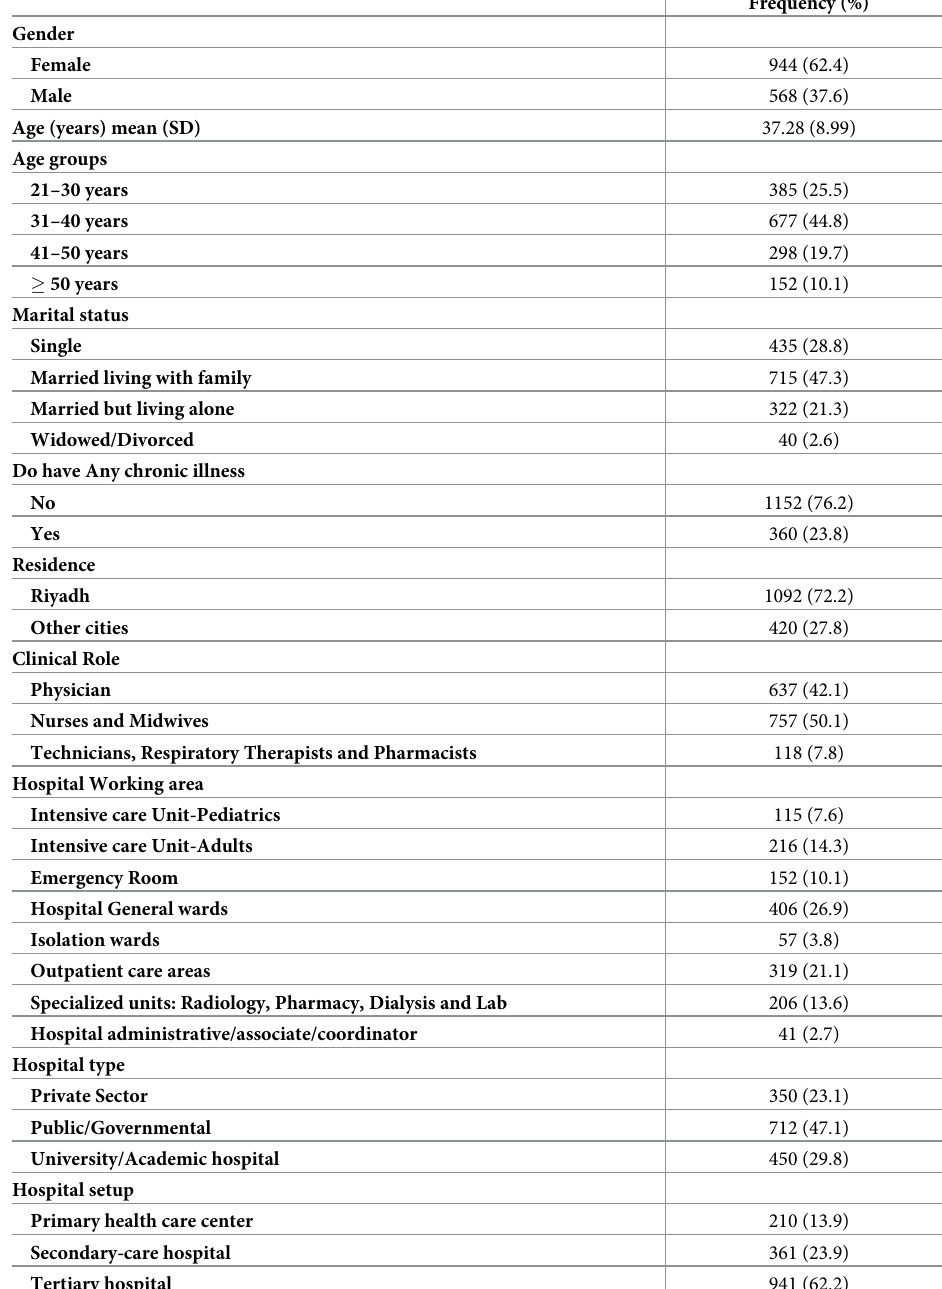
Table 1. Respondents’ sociodemographic and professional characteristics (N =